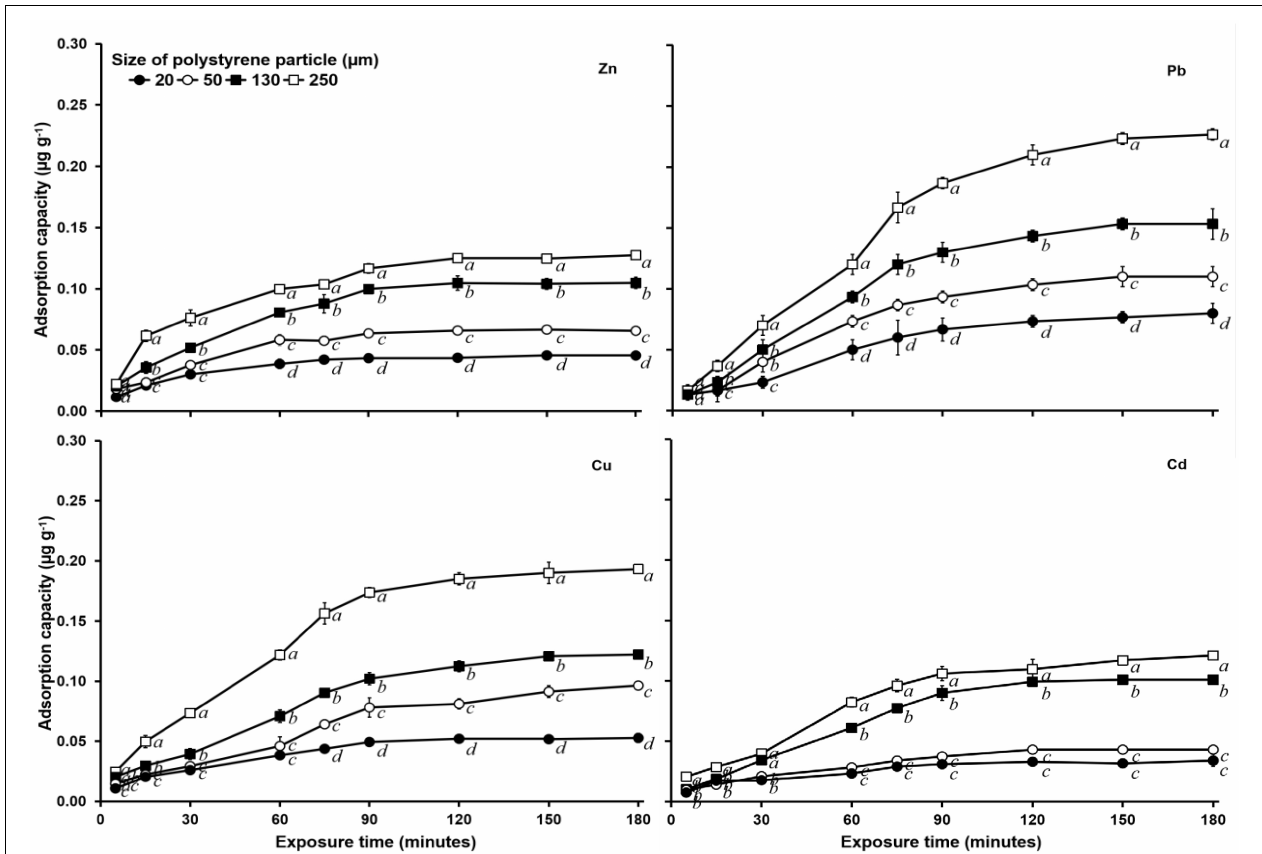
FIGURE 3 | Heavy metal (Zn, Pb, Cu, and Cd) adsorption capacity ( µ g g − 1 ) of PS of different sizes (20, 50, 130, and 250 µ m) with a 1 mg L − 1 heavy metal concentration and salinity of 30 . See Figure 1 for statistical information. (cid:104)